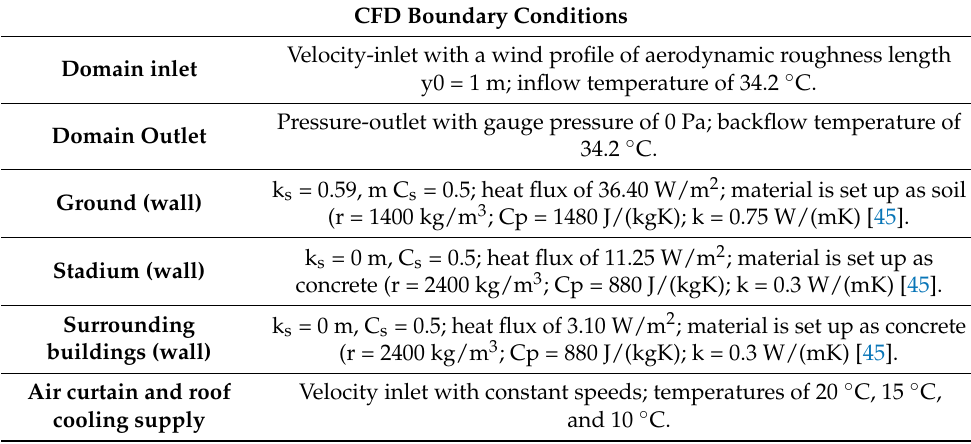
Table 1. Boundary conditions for the CFD simulations.